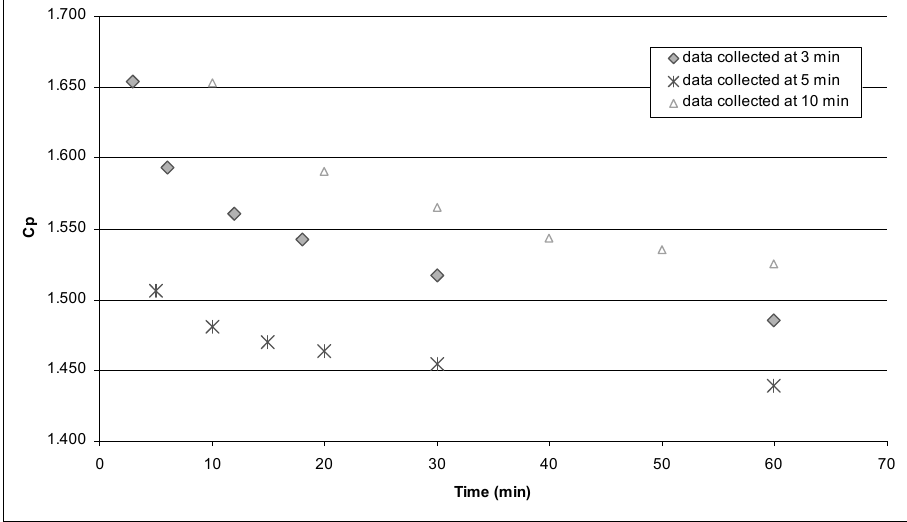
Figure 3. Example of daily water flow recorded during the measurement campaign (town: Crispiano).